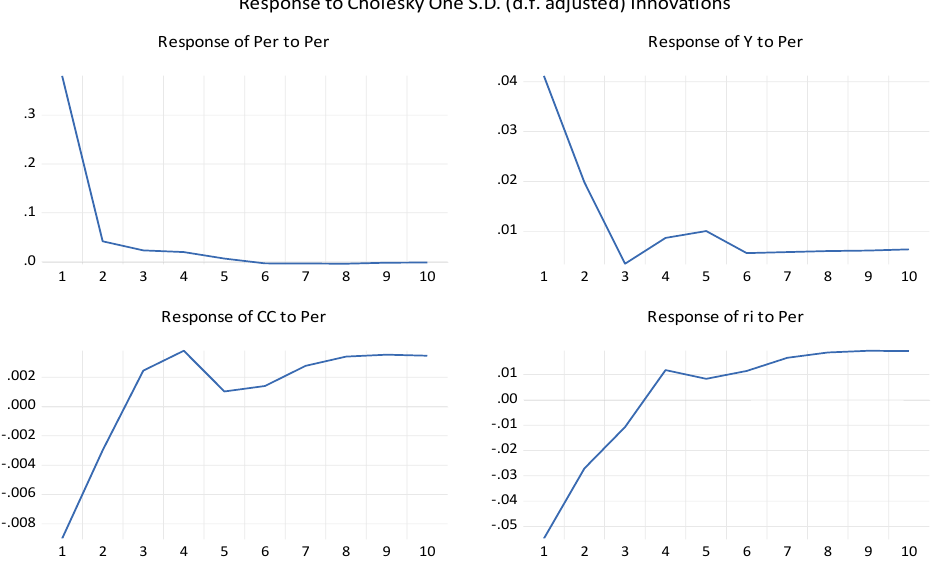
Figure 2. The response of housing permit to housing demand in Ankara, Turkey. 4.3.3. Istanbul (Housing Demand Model) The expected inflation, shock on price, and nominal interest rate are inversely associ- ated with demand in the short-term (see Figure 3).